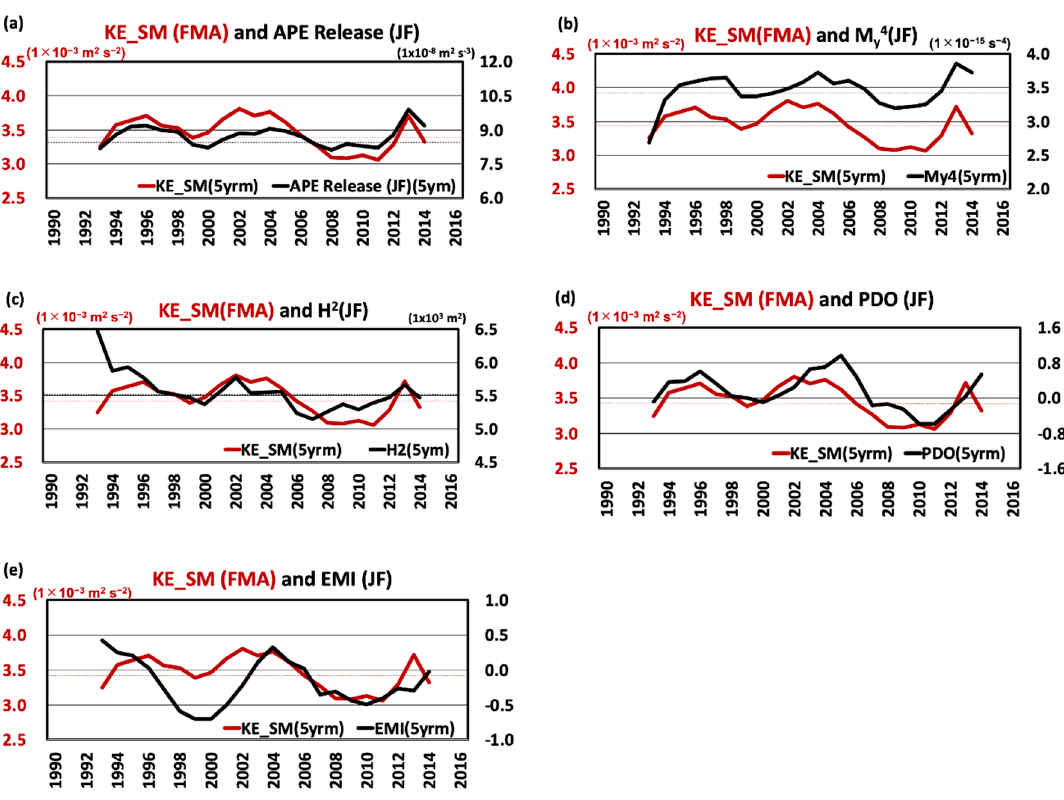
Figure 8. Time series of five-year running mean of submesoscale KE (KE_SM) averaged from February to April (red curve) and ( a ) parameterized APE release from January to February (black curve) in the STCC region. Black curves of ( b – e ) are the M y4 and H 2 in the STCC region, Pacific Decadal Oscillation (PDO) index (http://research.jisao.washington.edu/pdo/), and El Niño Modoki index (EMI) (http://www.jamstec.go.jp/frsgc/research/d1/iod/modoki_home.html.en) averaged from January to February respectively.